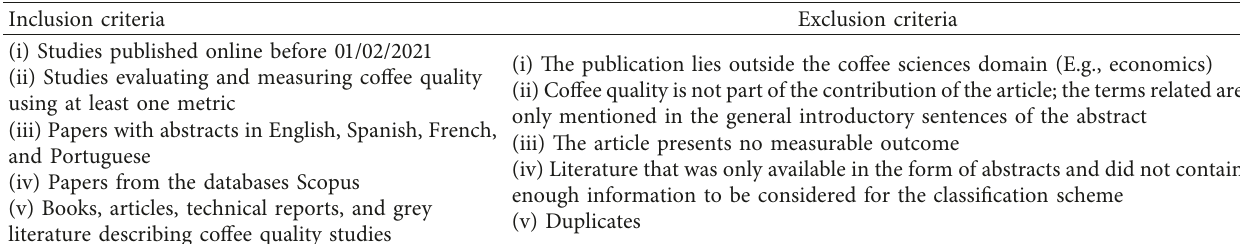
Table 2: Inclusion and exclusion criteria.